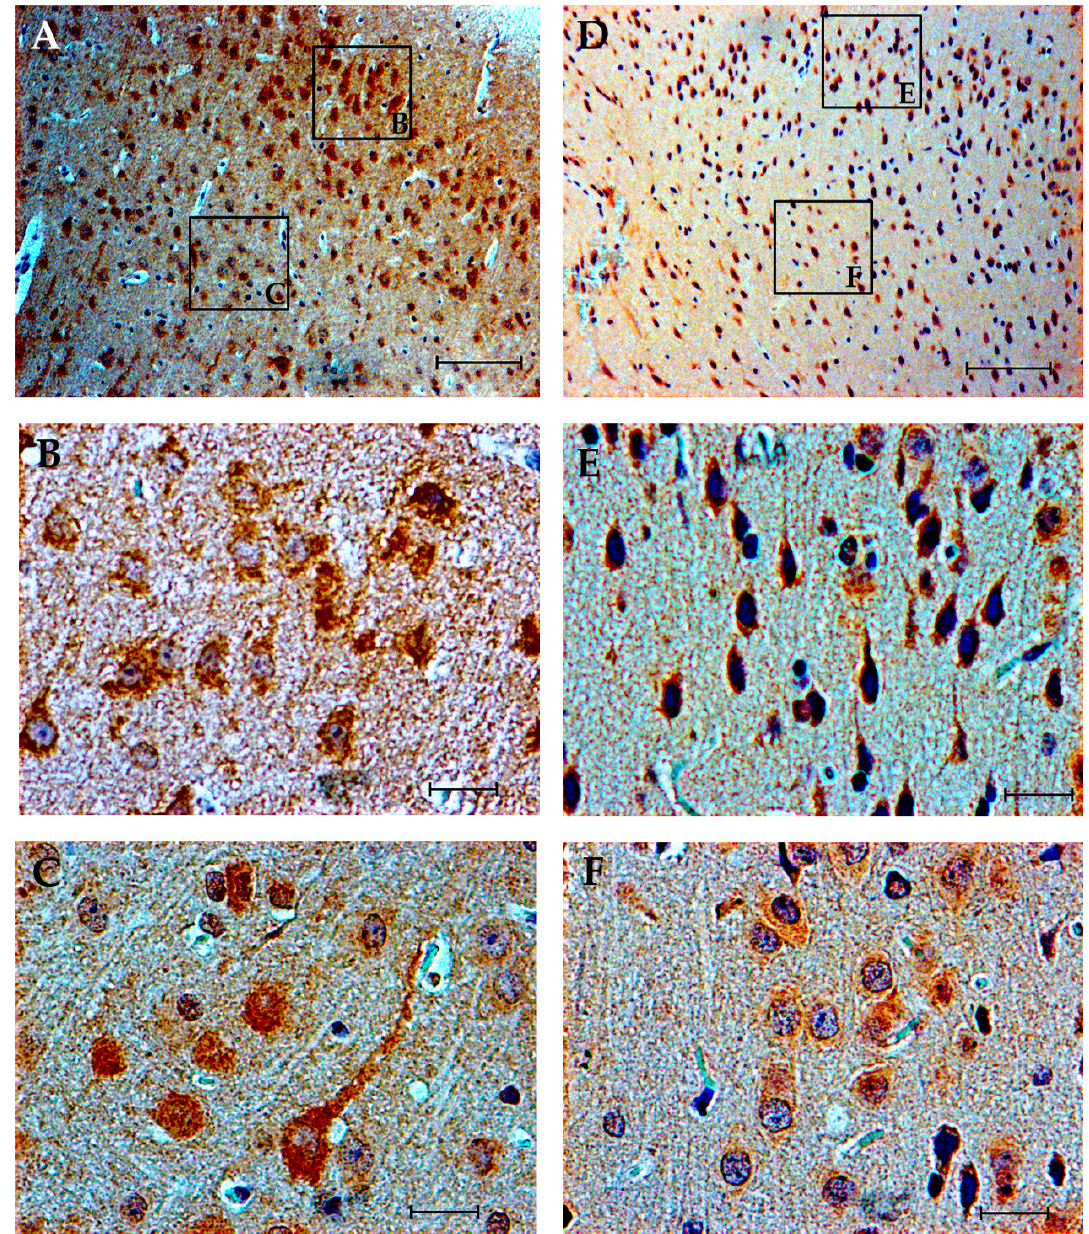
Figure 4. Cxcl16 expression in cingulate cortex (cg1 and cg2). ( A – C ) ISO group. Cytoplasmic expression appreciated in the soma of neurons of all layers, with predominance in zone III and V, as well as in the neuropile. ( D – F ) EtOH group. Expression persists in the neuronal soma; however, the intensity of expression is notably lower and seems to be restricted to layer V, with few positive cells in layer III. In the neuropile, the intensity of expression is significantly lower. Scale bar in ( A , D ) = 100 µ m. Scale bar in ( B – D , F ) = 20 µ